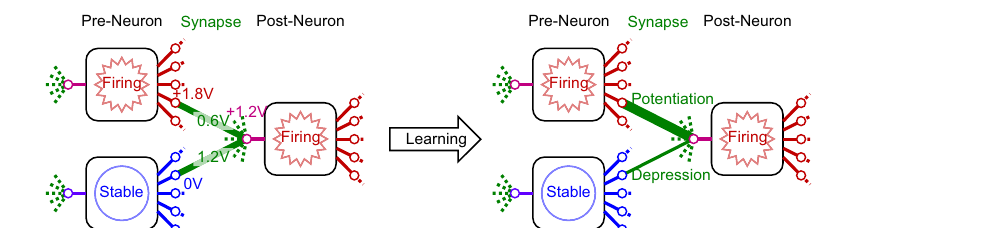
Figure 3. Local autonomous